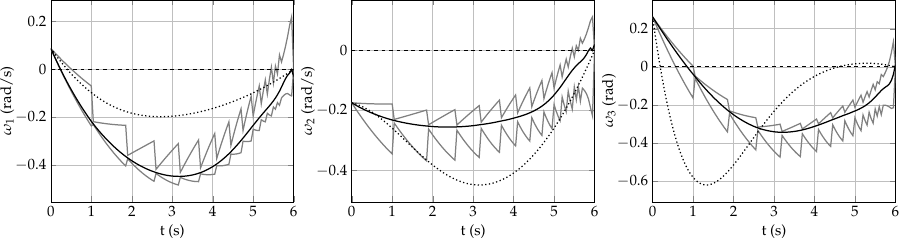
Figure 9. Angular velocity of the spacecraft. The black curves are the angular velocity of the actual nonlinear system, whereas the gray curves are the angular velocities of the auxiliary linear systems. The dashed line is the desired angular velocity and the dotted line a solution using a non-convex